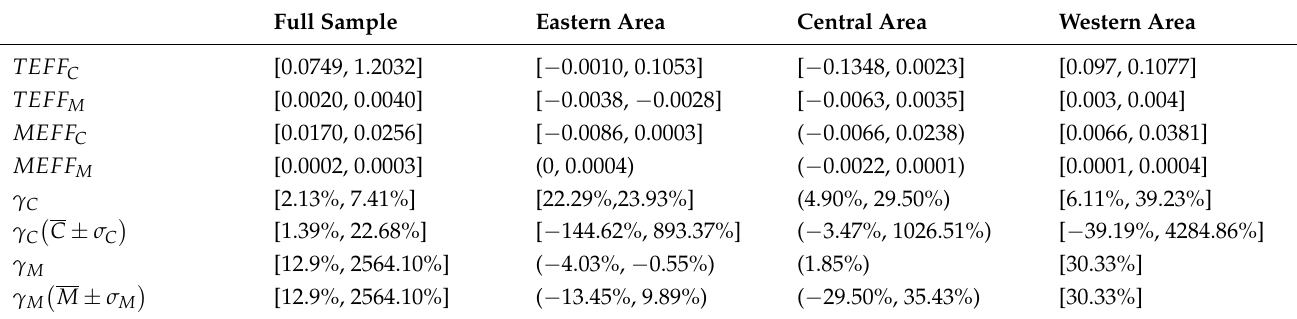
Table 10. Mediating effects and total